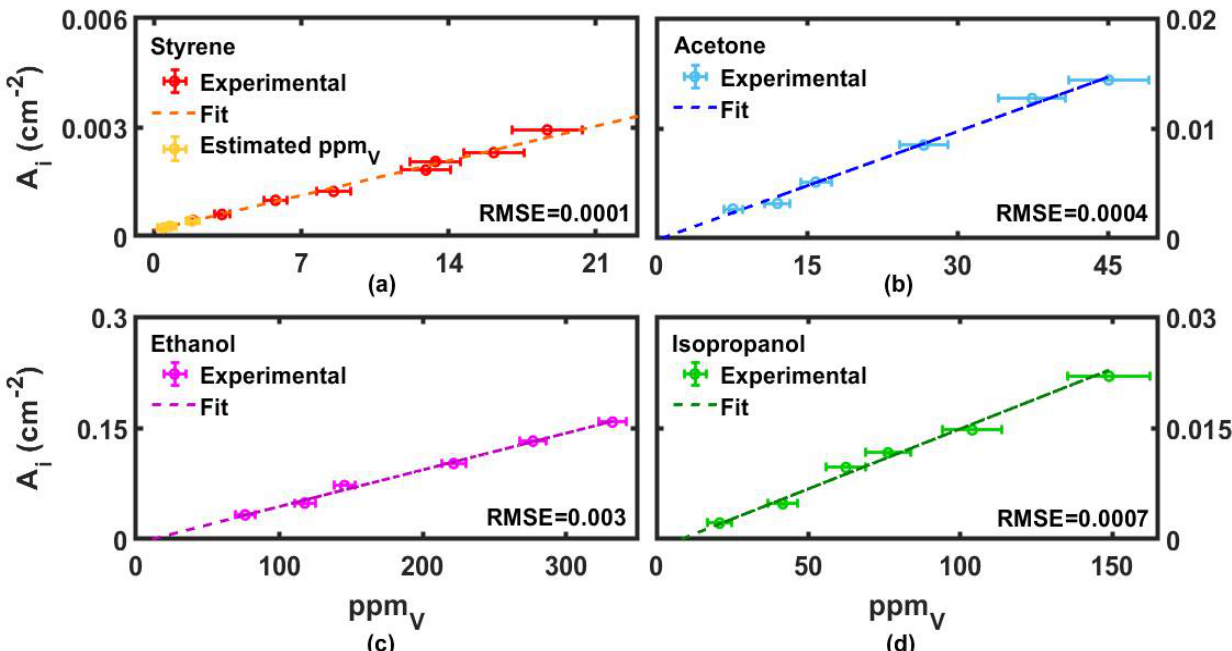
Figure 3. Calibration curves for styrene ( a ), acetone ( b ), ethanol ( c ) and isopropanol ( d ), referred to as the integrated absorbances A i vs. ppm v . The experimental data are indicated by points and the fit curves by the dashed lines. In panel ( a ), we reported the A i related to sub-ppm v concentrations in yellow, indirectly estimated. The root-mean-square error (RMSE) was used for the estimation of the differences between the experimental values and the adopted linear model. (The integrated area errors are 0.1 × 10 − 4 cm − 2 ). Table 1. Slope and intercept associated with the linear fit of styrene, acetone, ethanol and